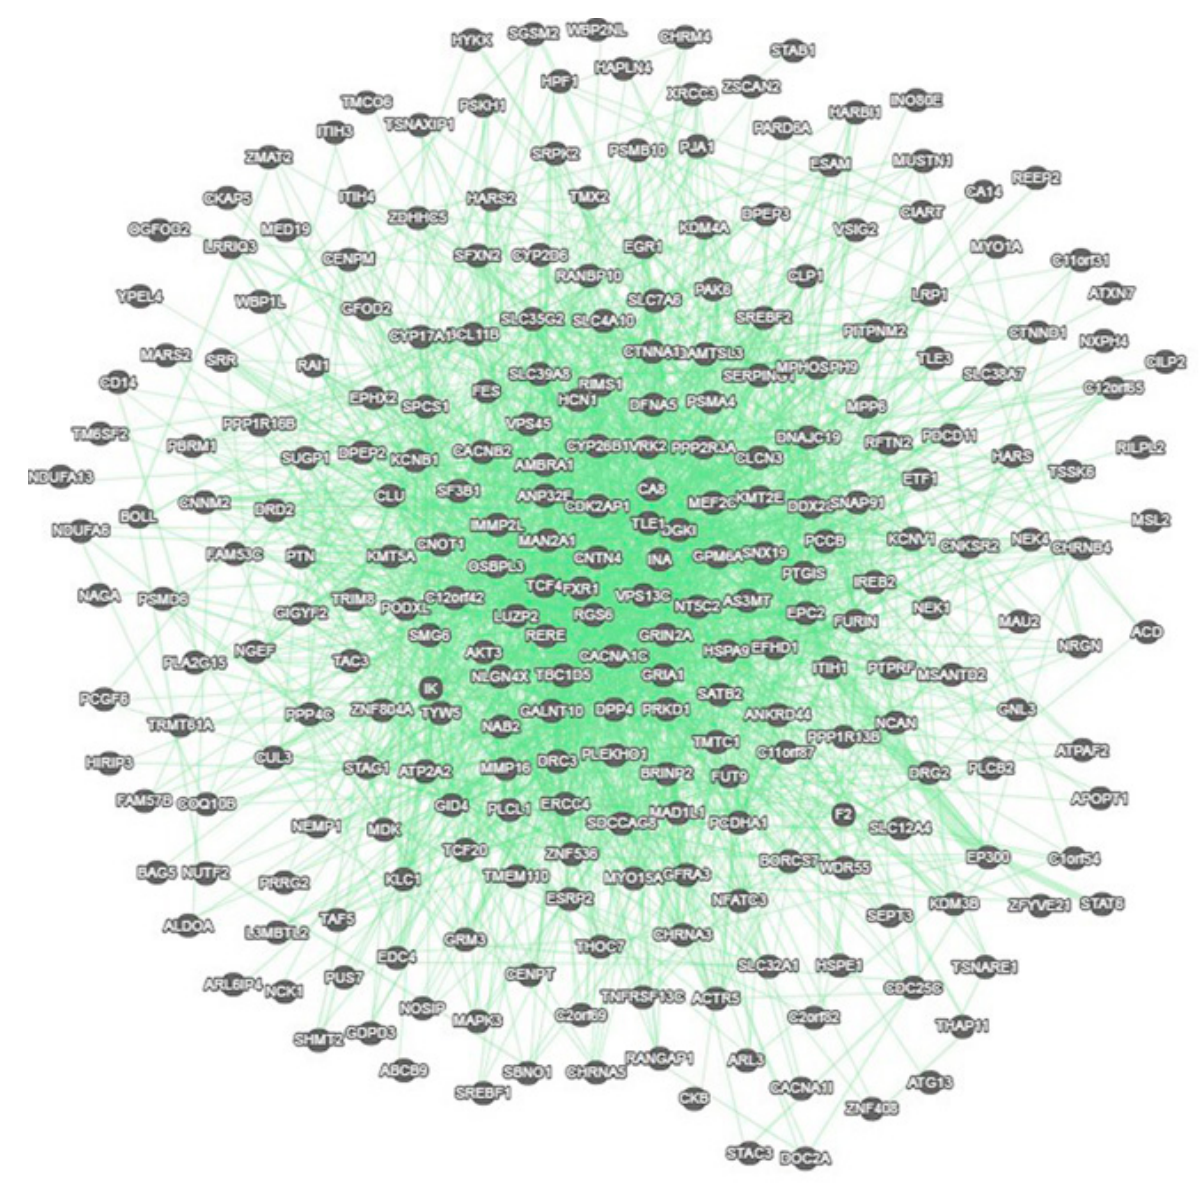
Figure A2. Network of genetic interactions derived from GeneMANIA analysis of the PGC list of candidate risk genes for schizophrenia. Links are indicated as before. The density of interactions is higher than in Figure A1, as quantified in Figure 4.